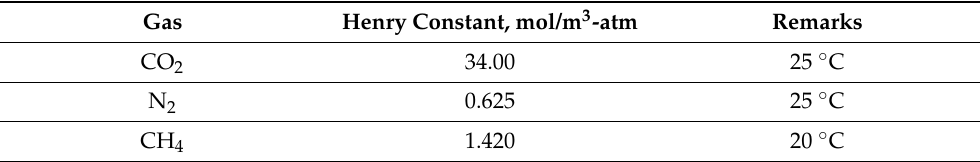
Figure 6. Schematical representation of membrane contactor apparatus for the gassing process of gas mixture (CH 4 /CO 2 ). Table 1. Henry constants of gases in water published in a literature [18].